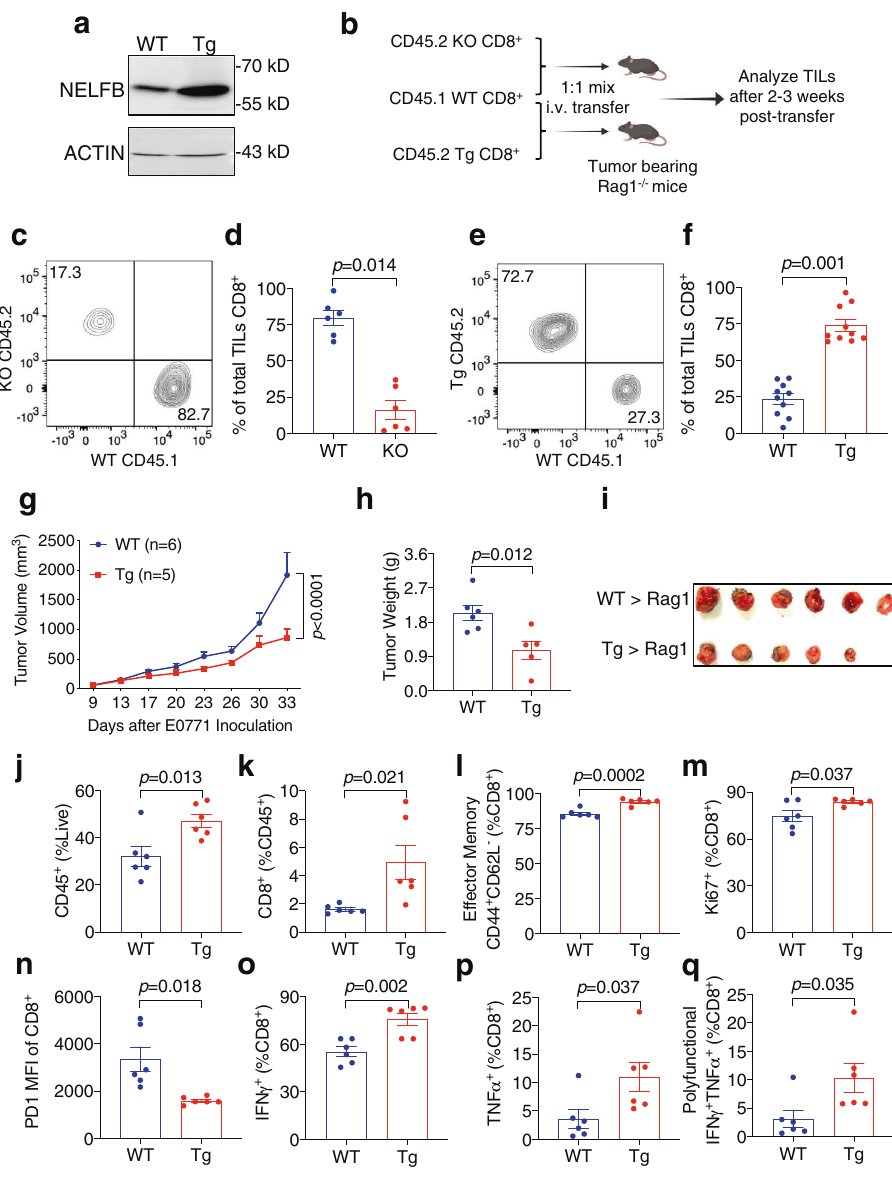
Fig. 7 NELFB overexpression promotes the tumor-killing capacity of CD8 + T cells. a Representative Western blots for NELFB and ACTIN in WT/Tg splenic CD8 + T cells. The experiments were independently repeated three times with similar results. b Scheme of competitive co-transfer assay. c Representative fl ow cytometry plot of TILs in the mice that received WT/KO CD8 + T cells. d Percentage of total TILs CD8 + cells in mice receiving WT/ KO CD8 + T cells, n = 6/group. e Representative fl ow cytometry plot of TILs in mice receiving WT/Tg CD8 + T cells. f Percentage of total TILs CD8 + cells in mice receiving WT/Tg CD8 + T cells, n = 10/group. g – i E0771 tumor growth curve ( g ), weight ( h ), and image ( i ) in Rag1 − / − mice receiving WT or Tg CD8 + T cells; WT ( n = 6), Tg ( n = 5). j – q TIL analysis for E0771 tumors in Rag1 − / − mice receiving WT or Tg CD8 + T cells, n = 6/group. j CD45 + (% of total live cells), k CD8 + (% of CD45 + ), l effector memory CD44 + CD62L − (% of CD8 + ), m Ki67 + (% of CD8 + ), n Median fl uorescence intensity (MFI) of PD1, o IFNg + (% of CD8 + ), p TNFa + (% of CD8 + ), q polyfunctional IFN γ + TNF α + (% of CD8 + ). Data were presented as mean ± SEM; mean differences were compared using Student ’ s t -test. Tumor curves were compared using two-way ANOVA followed by multiple comparisons. Two-sided tests were used. Source data are provided as a Source Data fi